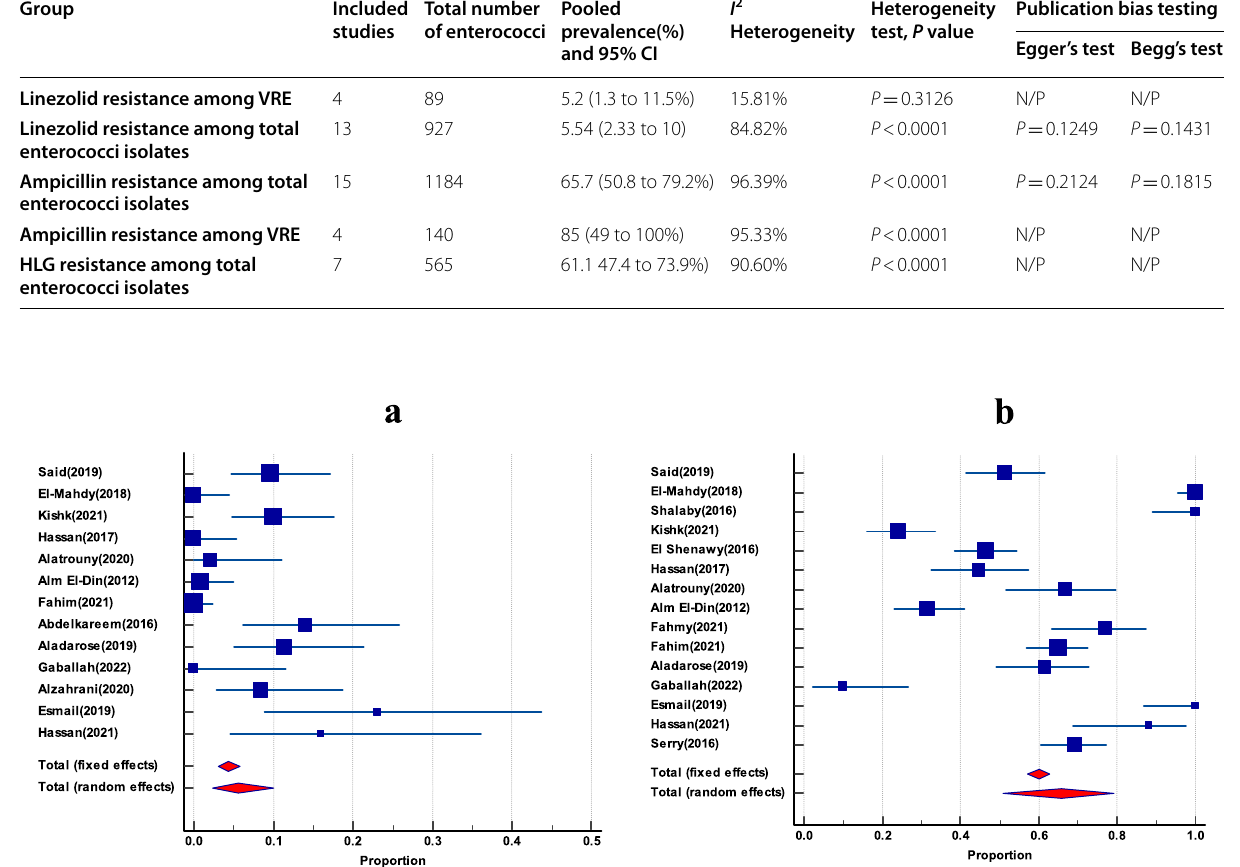
Fig. 8 The resistance profile of enterococci isolates to linezolid and ampicillin. a Forest plot of linezolid resistance among total enterococci isolates. b Forest plot of ampicillin resistance among total enterococci